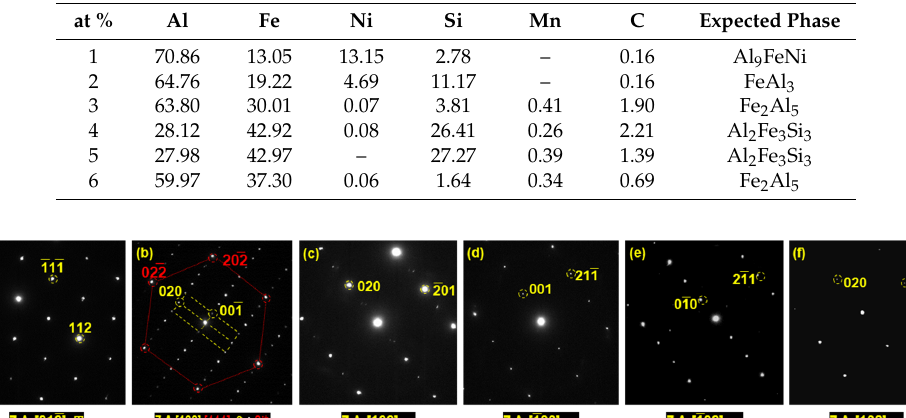
Figure 9. Diffraction patterns obtained from areas denoted by 1–6 in Figure 8. (T: Al 9 FeNi; θ : FeAl 3 ; Si*: Si (Fd ‐ 3m); τ 1 : Al 2 Fe 3 Si 3 ; η : Fe 2 Al 5 ).